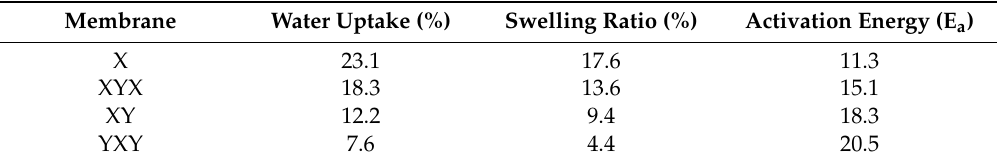
Figure 9. Proton conductivity plots of ( i ) blend and ( ii ) block copolymer membranes measured under 100% RH.